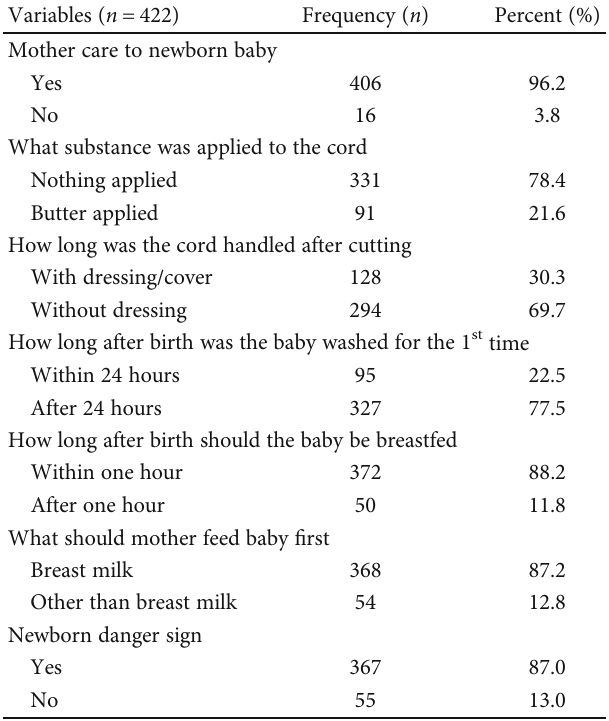
Table 4: Knowledge on newborn care and danger signs of mothers with babies of one-month-old in Hossana town, southwest Ethiopia, 2018 ( n = 422 ).